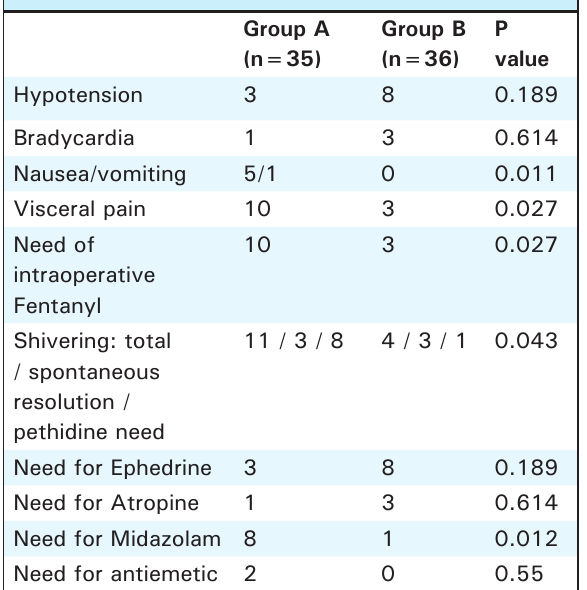
A (Table 4). Comparison of side effects and need for administration of medications during the study period are shown in Table 4. Table 4. Adverse effects and need for medications.